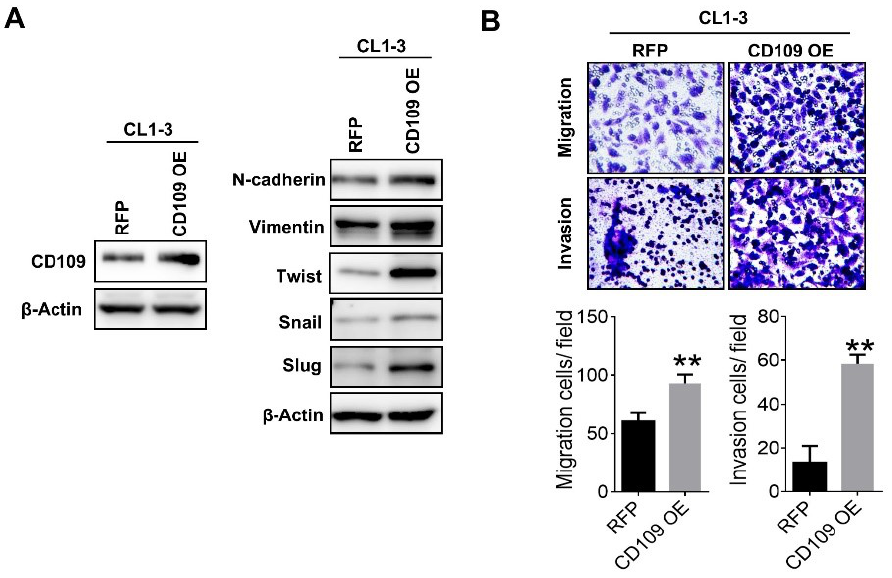
Figure 3. Overexpression of CD109 promotes the epithelial-to-mesenchymal transition (EMT) and tumor mobility. ( A ) Western blot analyses of CD109 (left panel) and EMT-related protein levels (right panel) in CD109-overexpressing CL1-3 cells. RFP, red fluorescent protein. ( B ) CL1-3 cells were transiently transfected with the CD109 plasmid, and migratory and invasive capacities were measured by transwell analyses. Data were derived from three random fields by three independent experiments, and results are expressed as the mean ± SD. ** p < 0.01, as determined by an unpaired t